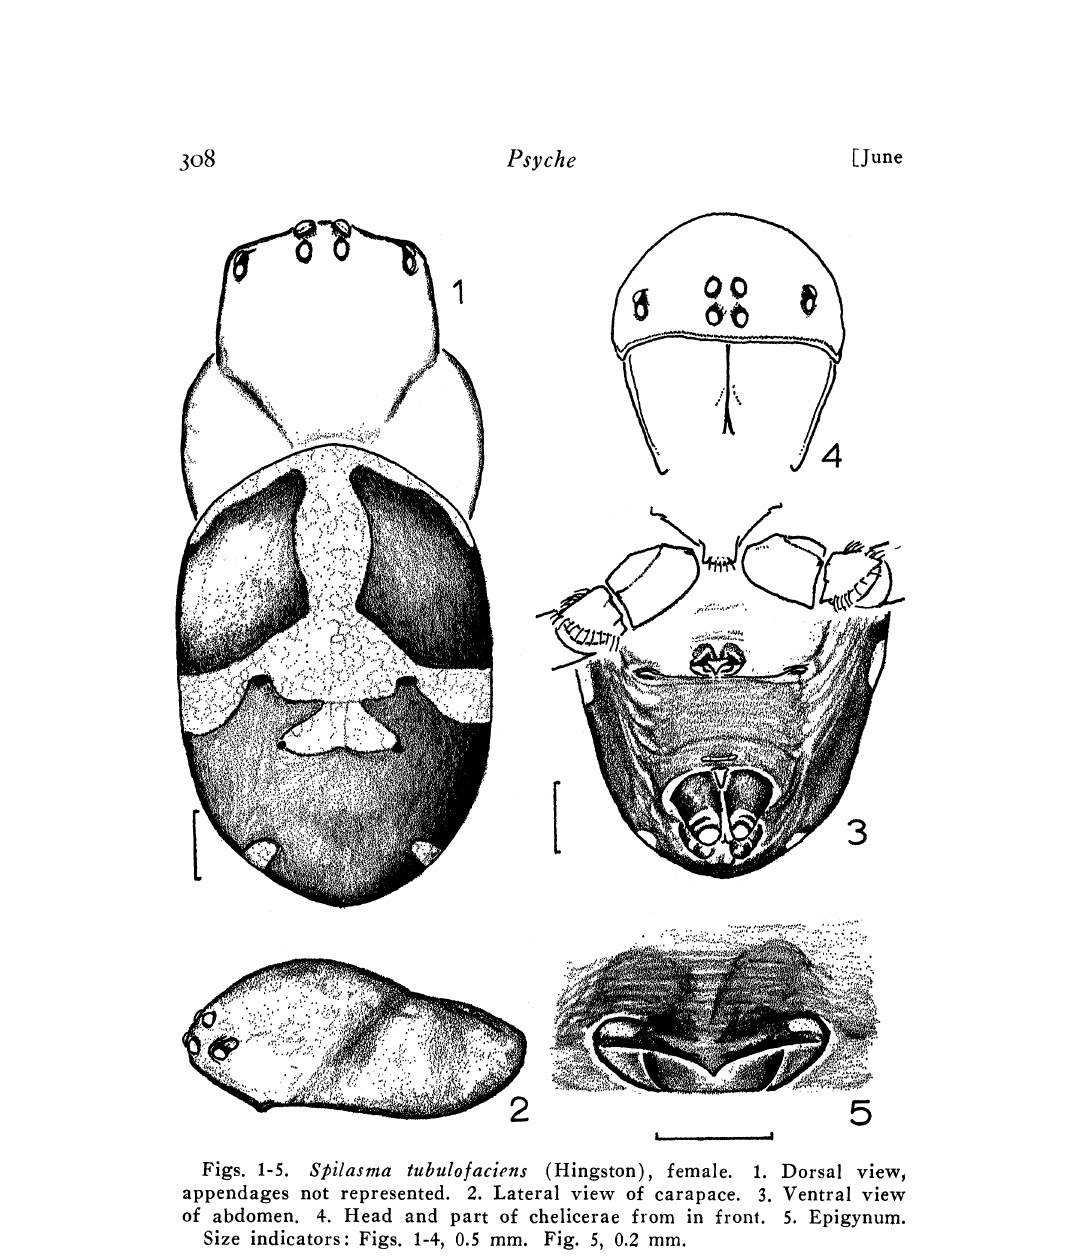
Figs. 1-5. Slilasma tubulofaciens (Hingston), female. 1. Dorsal view, appendages not represented. 2. Lateral view of carapace. 3. Ventral view of abdomen. 4. Head anti part of ehelieerae from in ronl. 5. Epigynum. Size indicators: Figs. 1-4, 0.5 ram. Fig. 5, 0.2